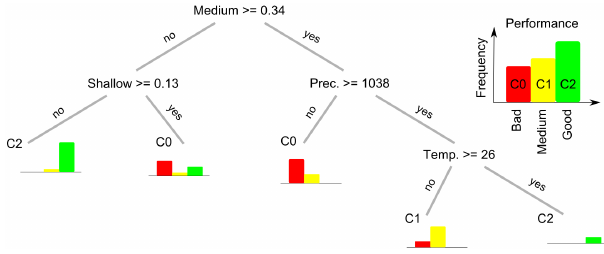
Figure 11. Classification trees relating regions of different KGE performance with physical and climatic characteristics. The bars represent the probability of a performance resulting in any of the three performance classes (C0, C1 or